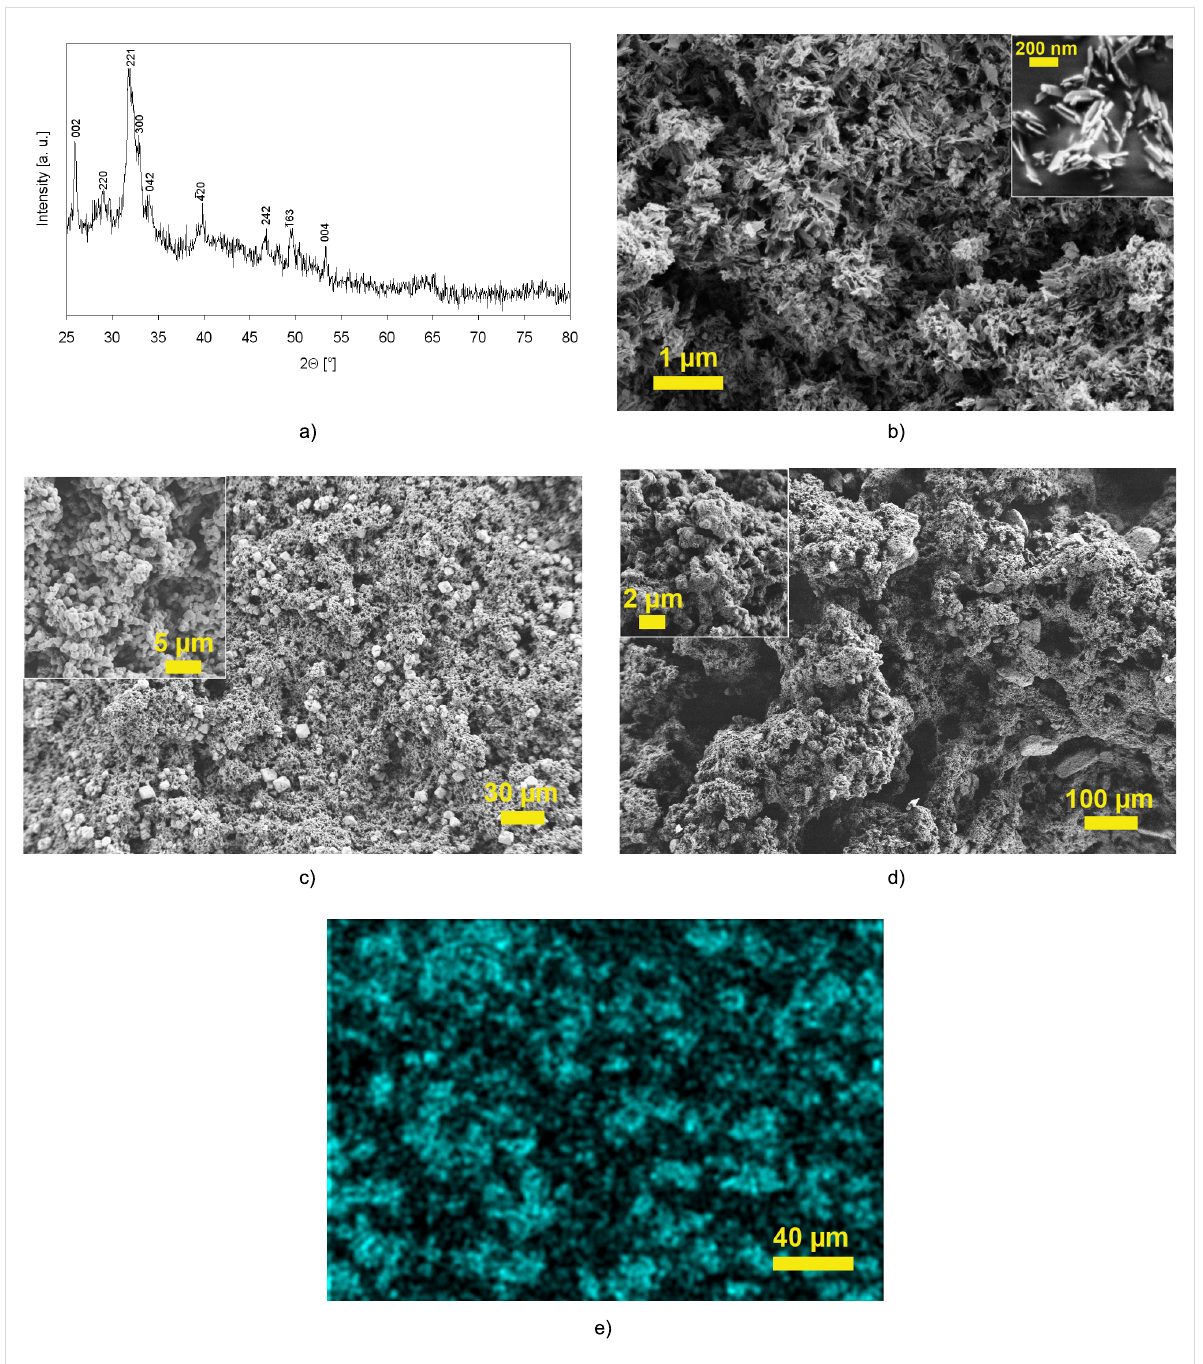
Figure 1: Nanoscale HAp : calcium phosphate hydroxide (Ca 5 (PO 4 ) 3 OH) as evidenced by XRD measurements (a), SEM picture of the nanoparticles (b), structures of COE -derived monoliths containing 12 wt % CaCO 3 (c) and 12 wt % HAp (d), and EDX-measurements of a monolith containing 12 wt % CaCO 3 (Ca-mapping)